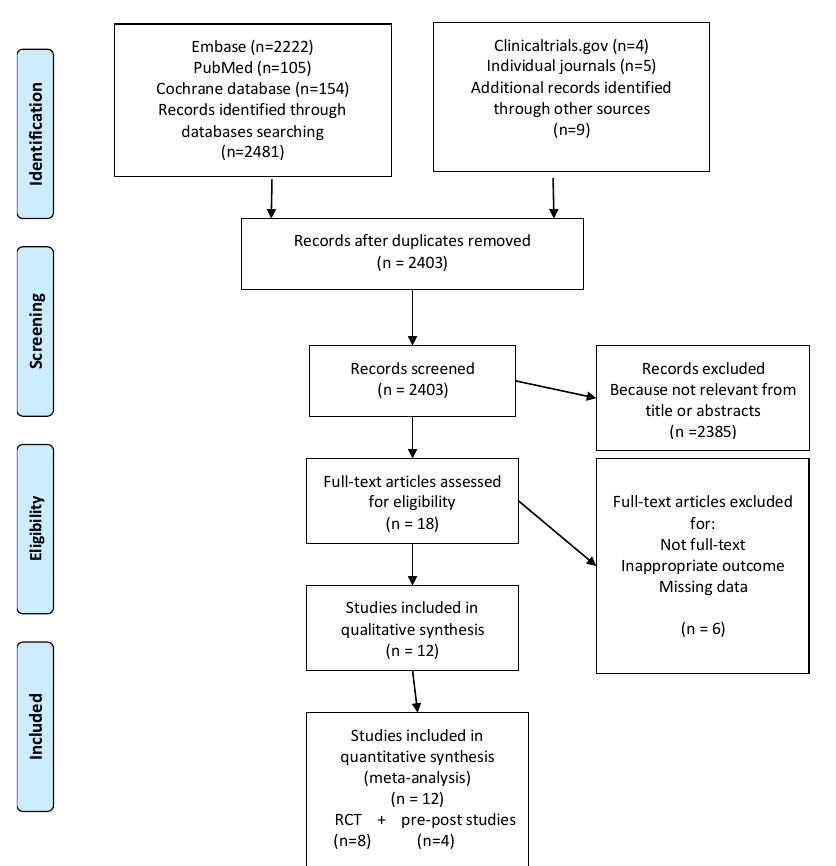
Figure 1. PRISMA flow diagram.